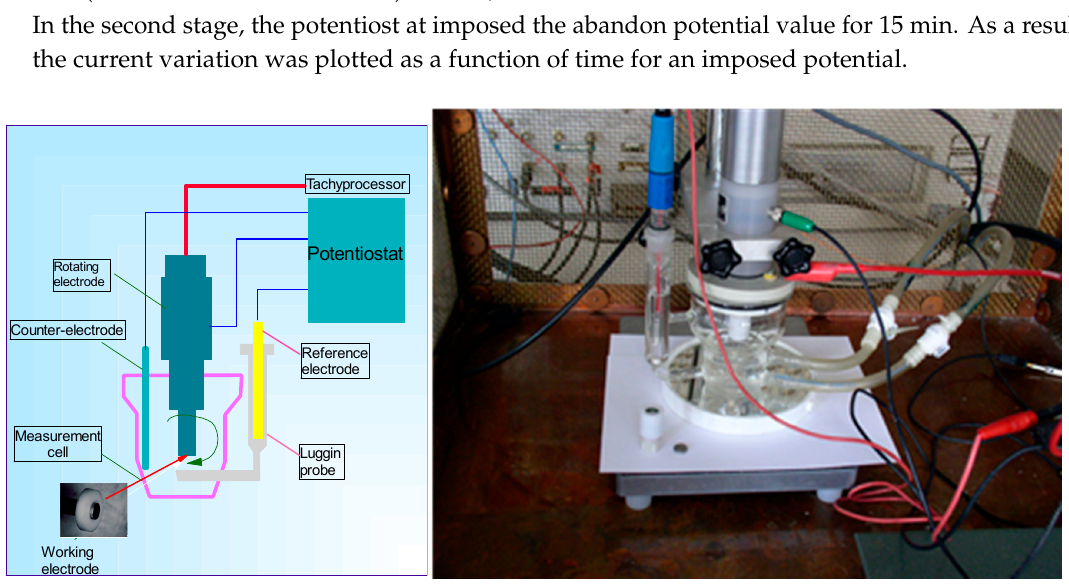
Figure 2. The electrochemical assembly and the electrochemical measuring cell.